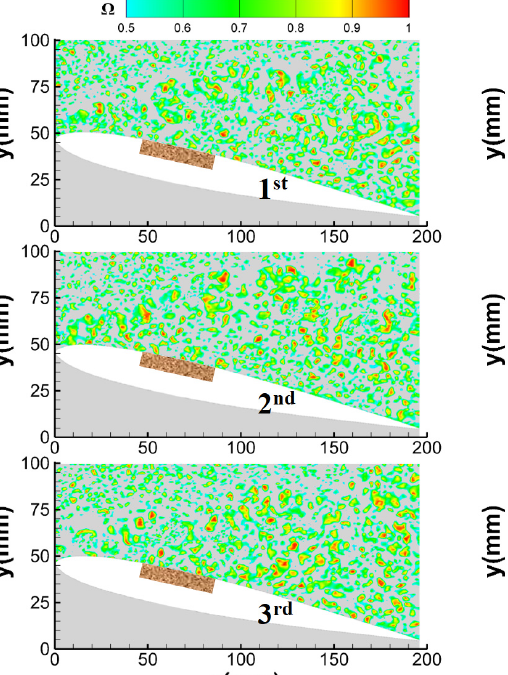
Table 2. First 15 DMD mode classification.